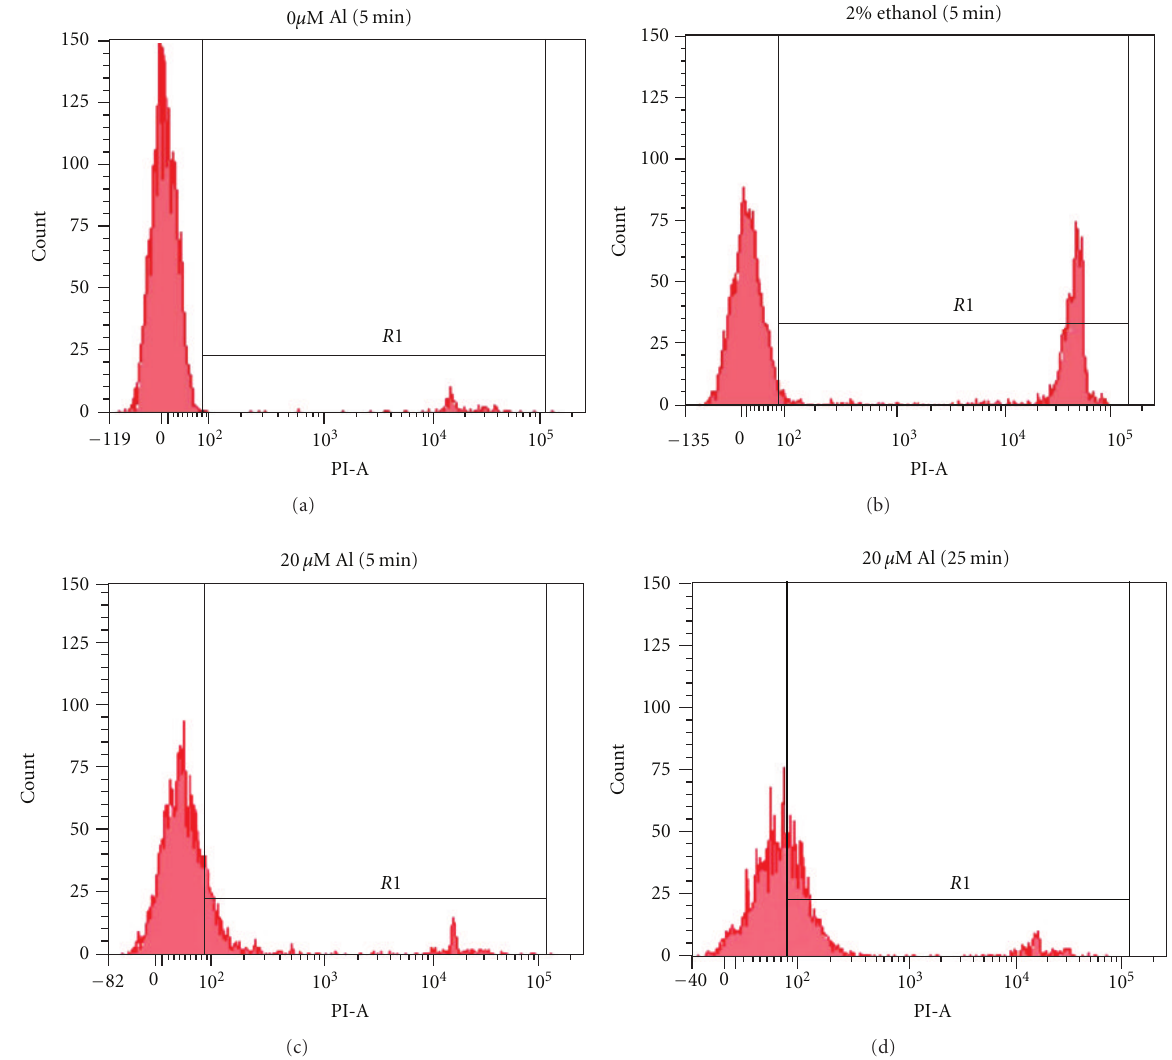
Figure 1: Histograms showing the e ff ects of aluminum exposure to thymocytes. PI fluorescence intensity ( x -axis) is plotted against cell count ( y -axis). Histogram (a) shows untreated thymocytes where most of the cells have low PI intensity, which is characteristic of healthy cells whose membranes exclude PI. In (b) thymocytes were exposed to 2% ethanol, and a large number of cells show very high PI intensity. These are dead cells, whose plasma membrane has lost integrity. (c) and (d) show the gradual increase in PI intensity in thymocytes exposed to 20 µ M of AlCl 3 at five- and 25-minute exposure. The number of dead cells did not increase with AlCl 3 exposure. There is, however, a shift in the distribution of healthy cells to the right, indicating an increased uptake of PI, reflecting cell damage. For purposes of quantitation, all cells falling under the bar labeled R1 are considered